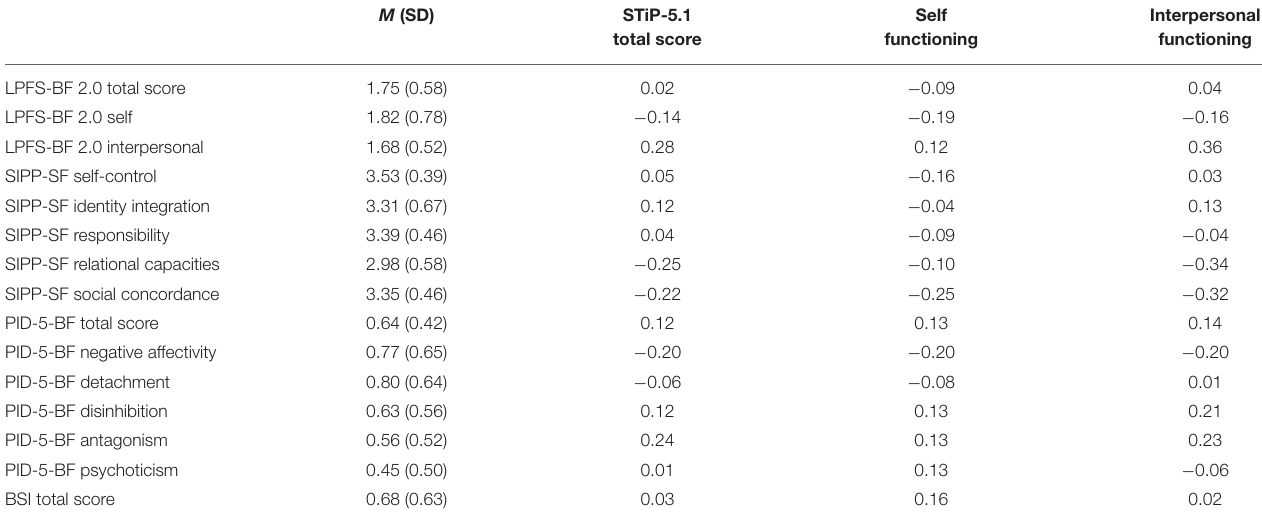
TABLE 3 | Means and standard deviations of self-report measures, and correlations of expert-rated personality functioning (STiP 5.1) with self-report measures of personality functioning and symptom severity ( N =